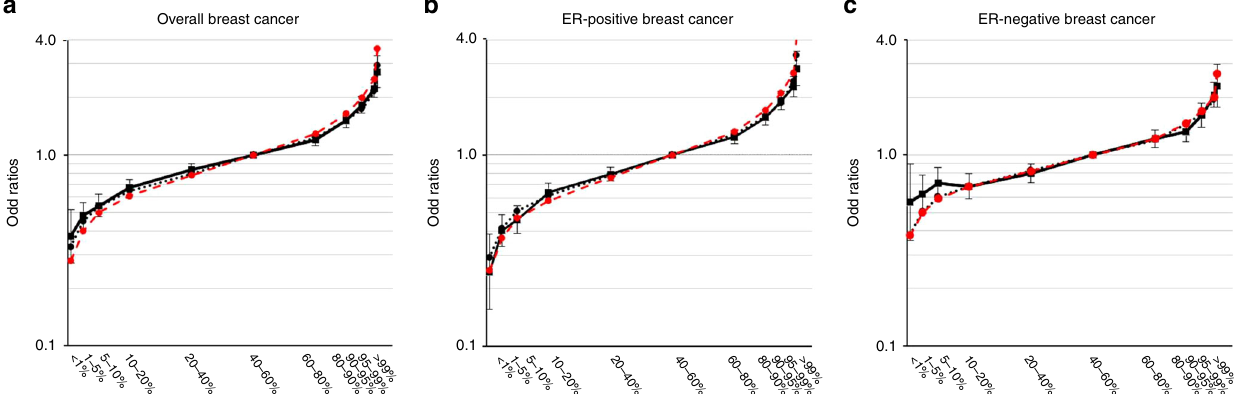
Fig. 2 Association between percentiles of 287-SNP polygenic risk scores (PRS) and breast cancer risk in combined Asian studies. The results for overall breast cancer, oestrogen-receptor (ER)-positive breast cancer and ER-negative breast cancer are shown in Fig. 2a – c, respectively. The squares/dots represent the odds ratios (ORs) and the vertical lines represent the corresponding 95% con fi dence intervals, with middle quintile (40 – 60th) as the reference category. Solid lines represent the observed ORs, black dashed lines represent the predicted ORs of PRSs under a multiplicative polygenic model in the Asian population and the red dashed line represent the predicted OR in the European population. The analysis was conducted using 15,755 cases and 16,438 controls. Of 15,755 cases, 9989 were ER-positive breast cancer while 4611 were ER-negative breast cancer. Source data are provided in Supplementary Table